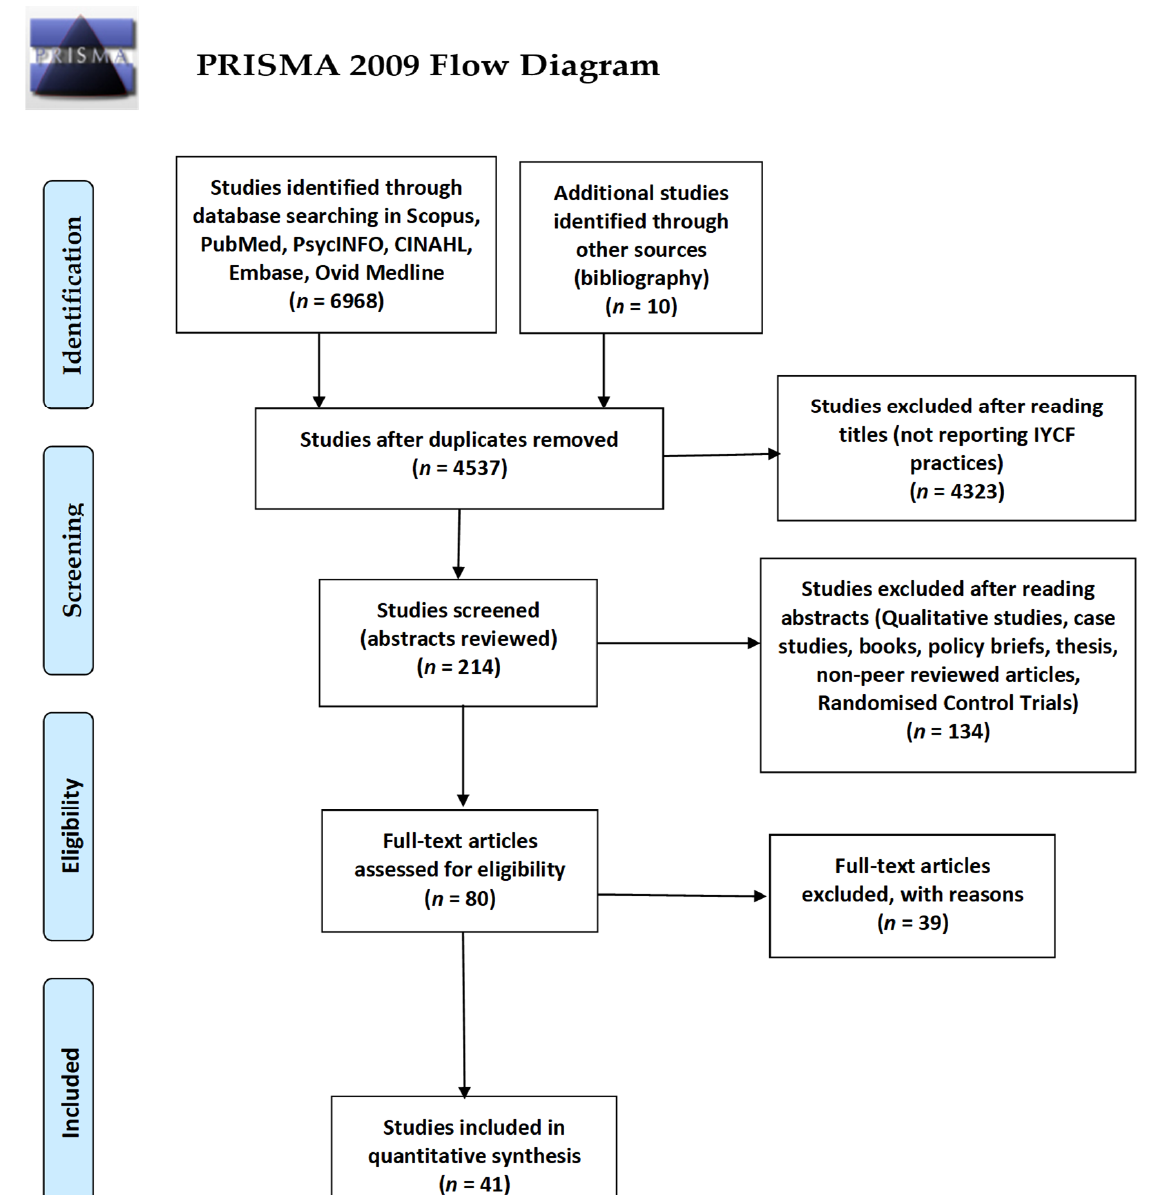
Figure 1. Flow chart for the study selection based on PRISMA 2015 guidelines.